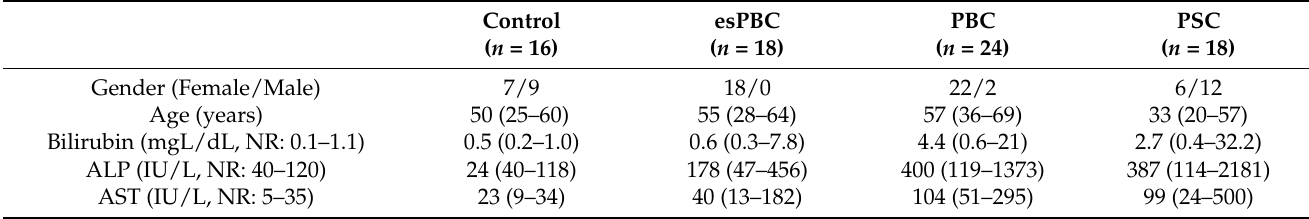
Table 1. Demographic and laboratory features of all analysed